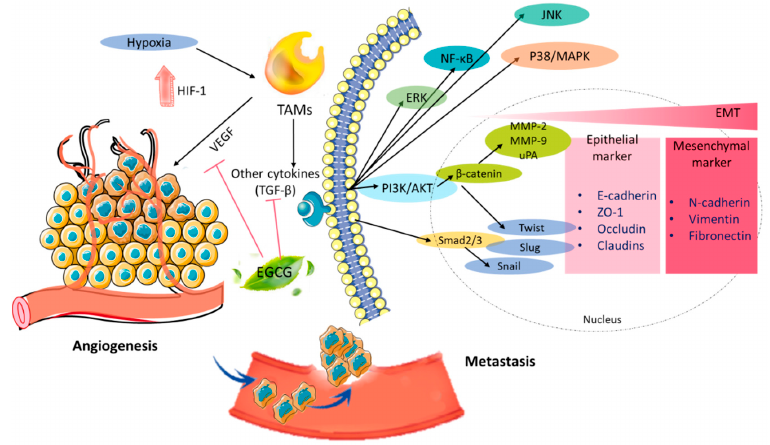
Figure 2. Molecular mechanisms of EGCG inhibition of angiogenesis and metastasis. EGCG downregulated the expressions of HIF-1 and multiple signal pathways, such as the PI3K/AKT, NF- κ B, and MAPK signaling pathways, to inhibit angiogenesis and metastasis. PI3K, phosphoinositide-3-kinase; AKT, protein kinase B; HIF-1, hypoxia-inducible factor 1; VEGF, vascular endothelial growth factor; TAMs, tumor-associated macrophages; TGF- β , transforming growth factor-beta; and NF- κ B, nuclear factor- κ B.